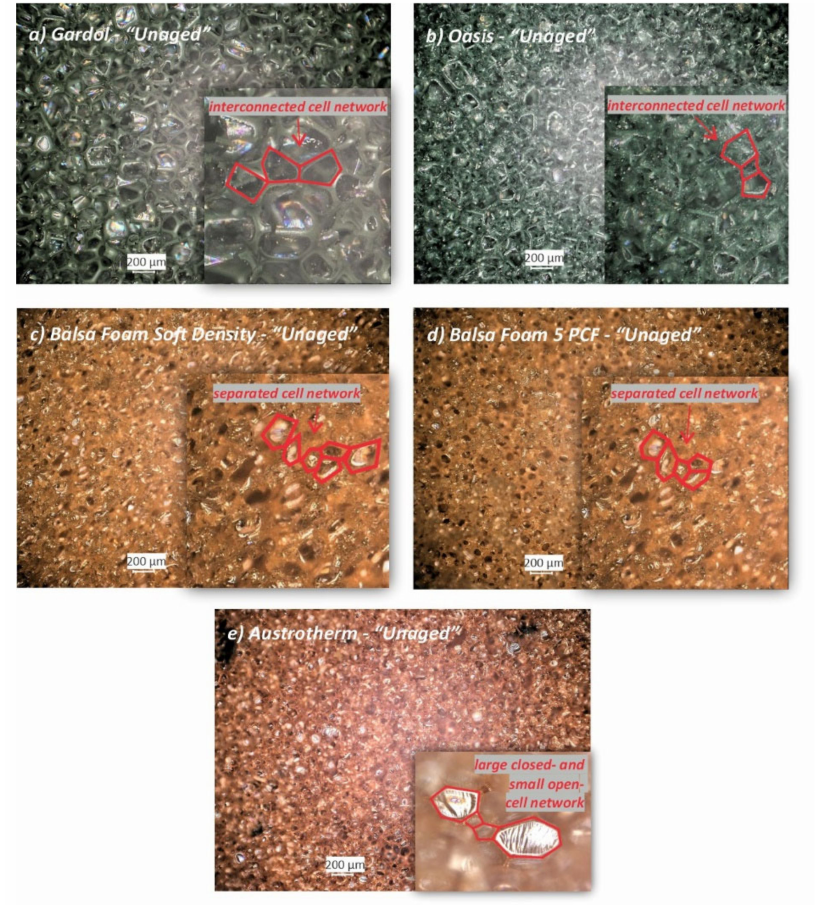
Figure 2. Photomicrographs of the “Unaged” phenol formaldehyde (PF) foams ( a – e ) investigated by a digital microscope with reflected